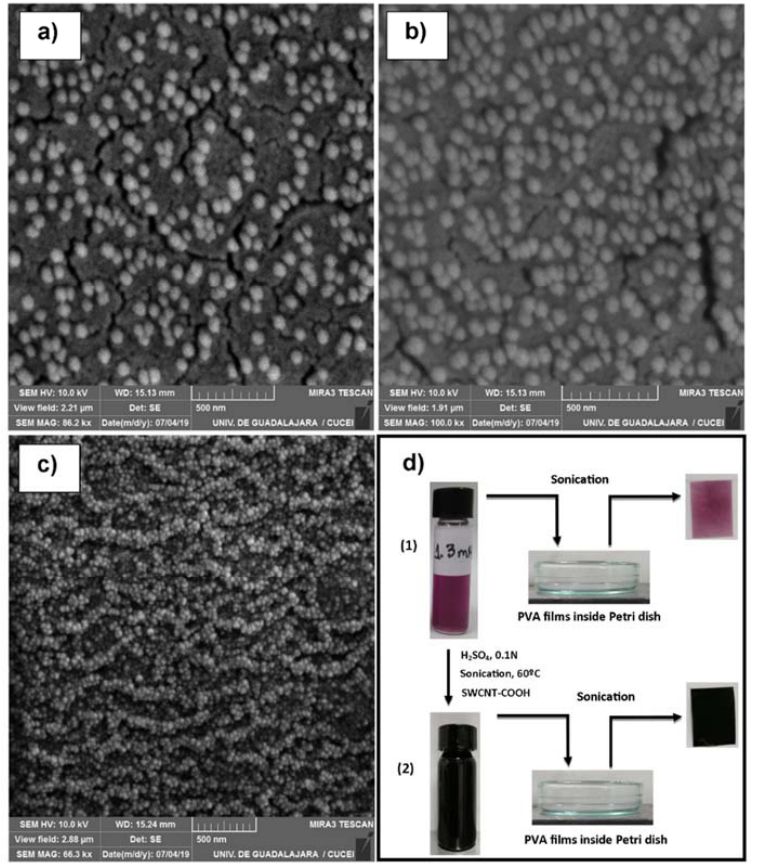
Figure 2. SEM image of PVA nanostructured films with: ( a ) chitosan ‐ AuNPs for a concentration of 0.4 and ( b ) 1.3 mM of HAuCl 4 ; ( c ) chitosan ‐ AuNPs/SWCNT ‐ COOH, and ( d ) schematic process to prepare PVA films with chitosan ‐ AuNPs (1), and PVA films with AuNPs ‐ Chitosan/SWCNT ‐ COOH (2).